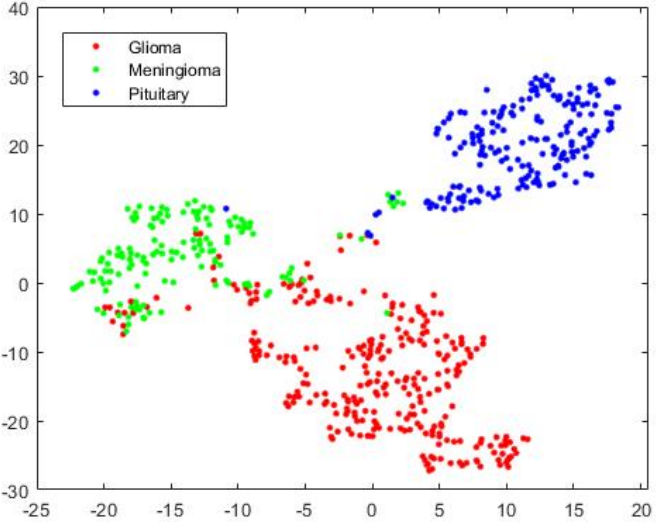
Figure 7. The 2D scatterplot for Hybrid Feature Space (1037 features) mapped to 2 dimensions using the “t-SNE” technique.